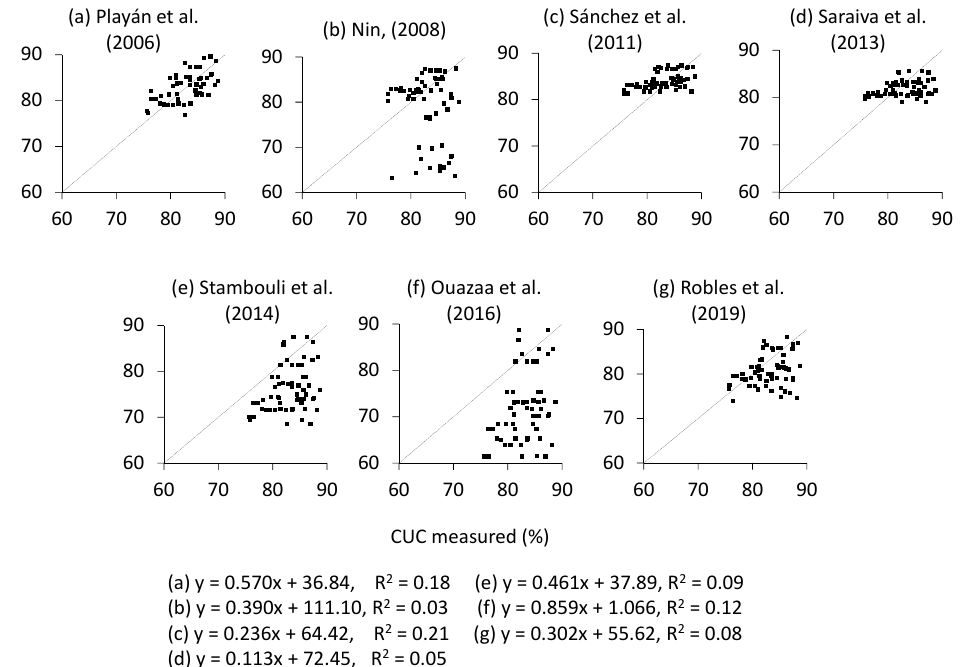
Figure 9. CUC estimates related to CUC models from different research works. Linear regressions and determination coefficient (R2) are reported for each correlation. [24,28,33,34,37–39].